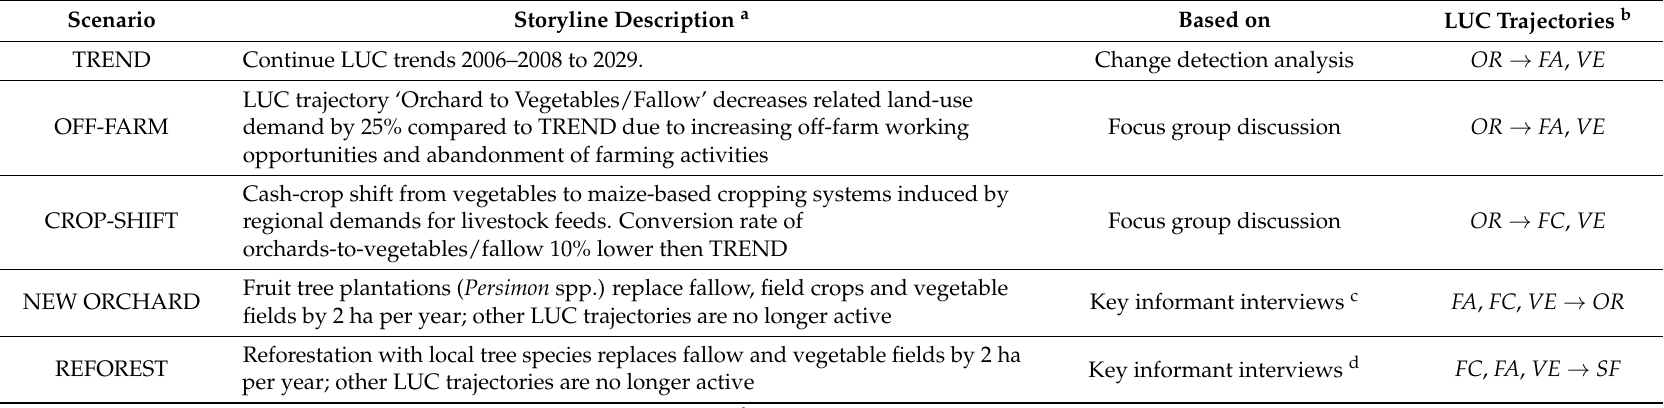
Table 2. Summary of scenario storylines and imposed land-use change trajectories simulated with Dyna-CLUE. Storylines build on outcomes of LUC analysis, participatory focus group discussions, and expert interviews.